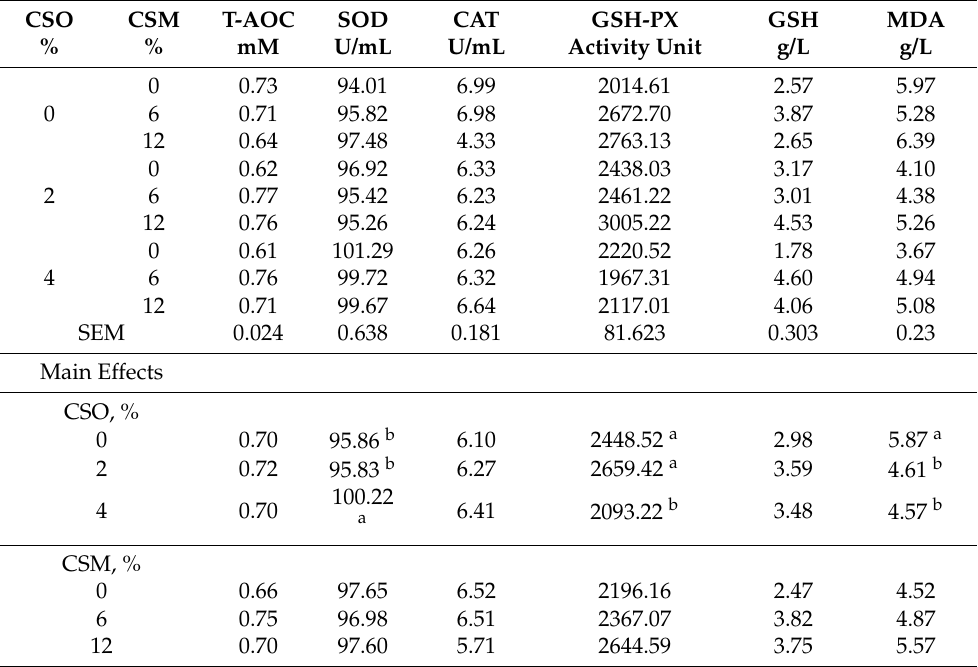
Table 8. Effects of cottonseed oil (CSO) and cottonseed meal (CSM) on serum antioxidant parameters in laying hens 1